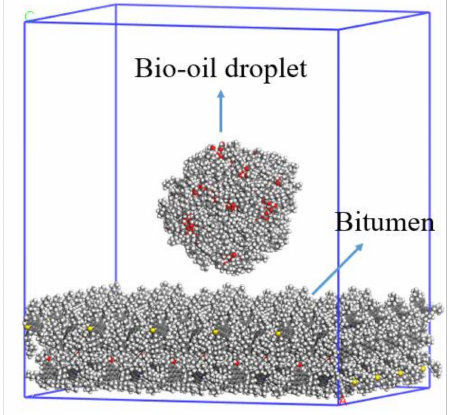
Figure 23. Bio-oil–bitumen interface wetting